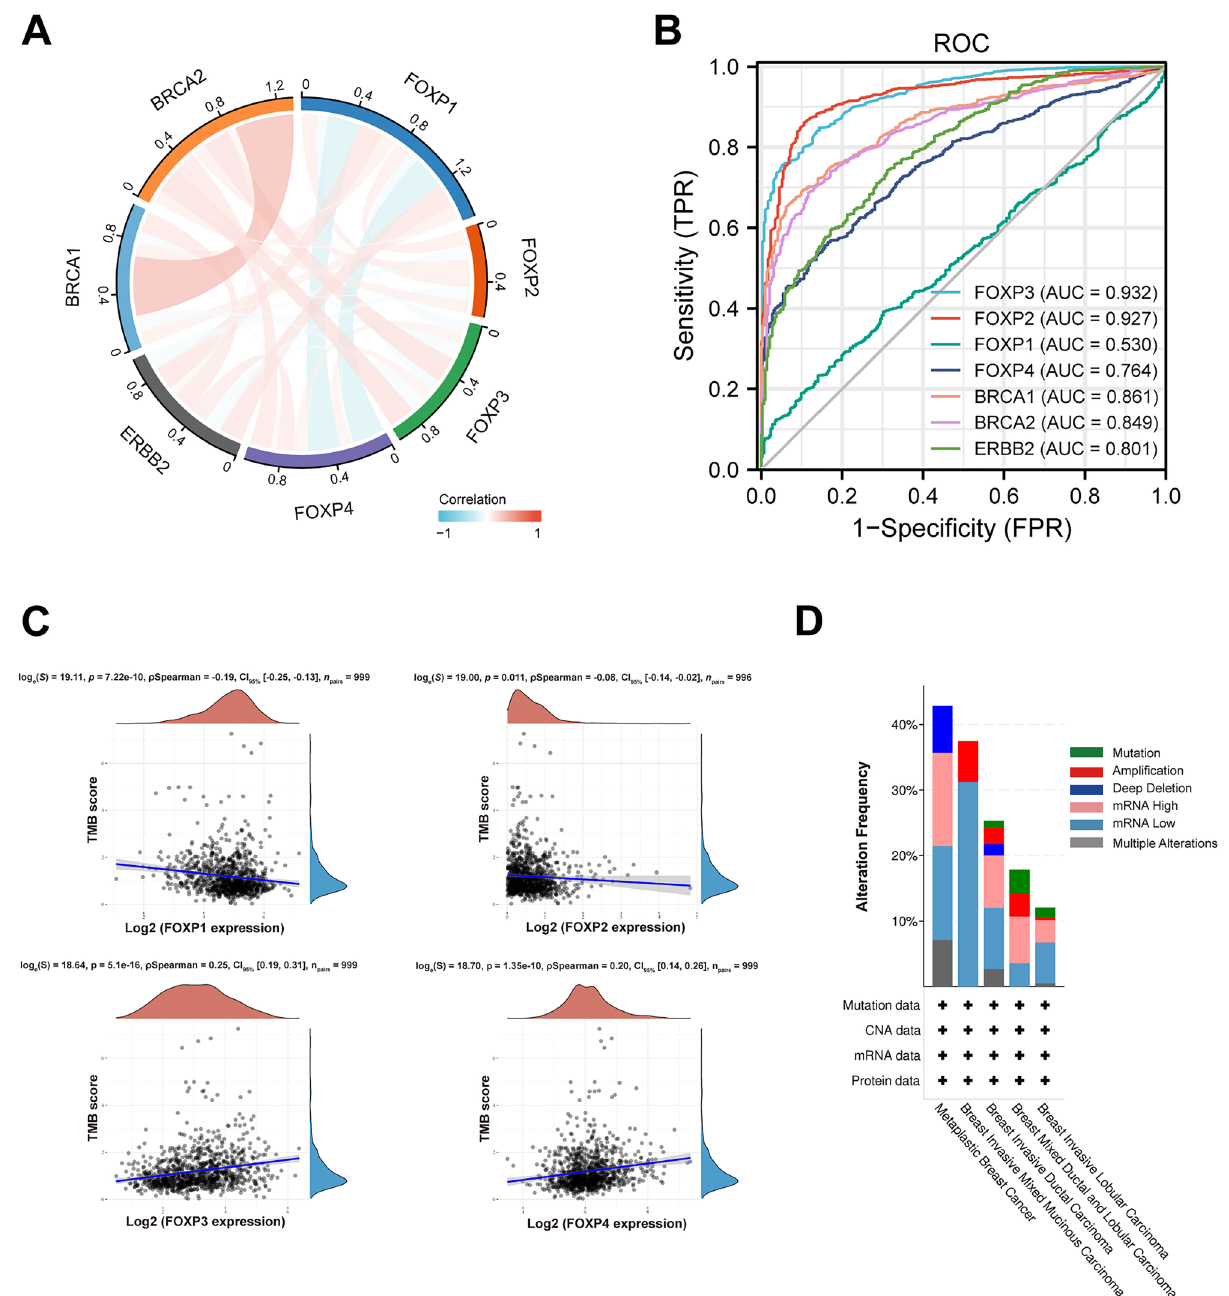
Figure 3. Relevance of different FOXPs and important genes, diagnostic value, TMB score and mutation analysis in BRCA. ( A ) Correction between different FOXPs and Important Genes in BRCA. ( B ) ROC curve analysis was performed to evaluate the diagnostic power of the FOXPs and Important Genes. ( C ) Correlation analysis of FOXPs expression and TMB in BRCA. The horizontal axis in the figure represents the expression distribution of the gene, and the ordinate is the expression distribution of the TMB score. The density curve on the right represents the distribution trend of the TMB score; The upper density curve represents the distribution trend of the gene; The top side: the value represents the correlation p value, correlation coefficient and correlation calculation method. ( D ) Summary of alterations in different expressed FOXPs and immune checkpoint in BRCA